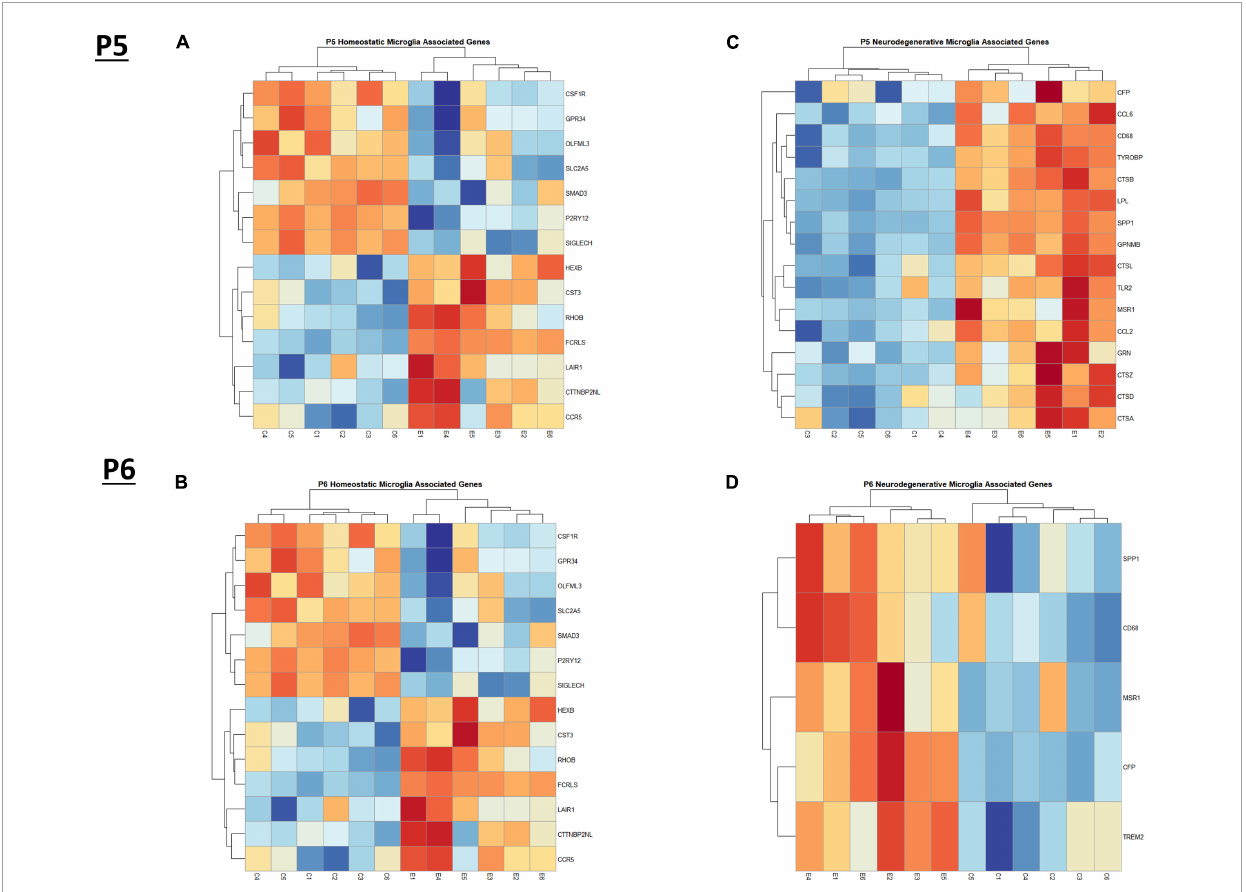
FIGURE3 Heatmap and hierarchical clustering of microglia associated genes at P5 and P6. R statistical software was utilized to construct heatmaps and hierarchical clustering dendrogram of relative gene expression across samples for significantly altered (adj. p < 0.05) and categorized microglia associated genes as detailed in Methods. Microglia homeostatic associated gene expression is depicted in panel (A) for P5 and panel (B) for P6. Microglia neurodegenerative associated gene expression is depicted in panel (C) for P5 and panel (D) for